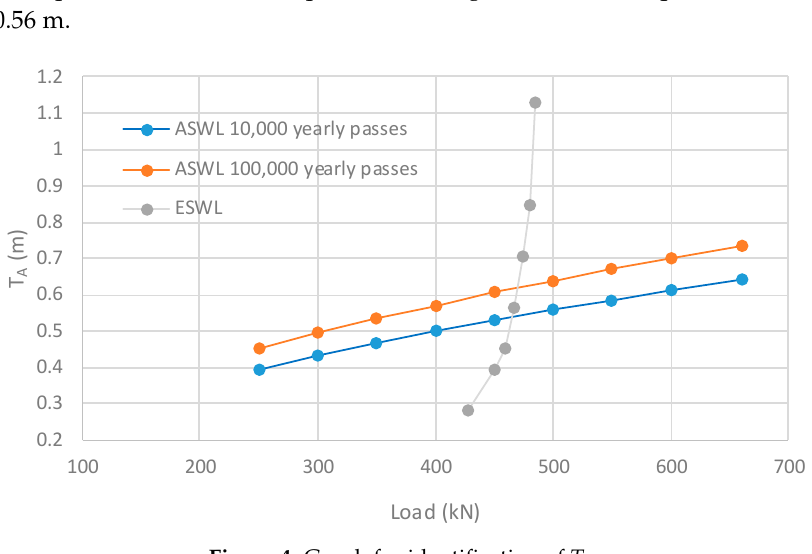
Figure 4. Graph for identification of T A .